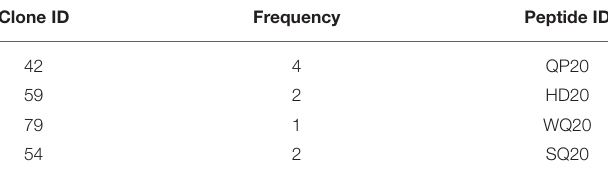
TABLE 1 | Selected